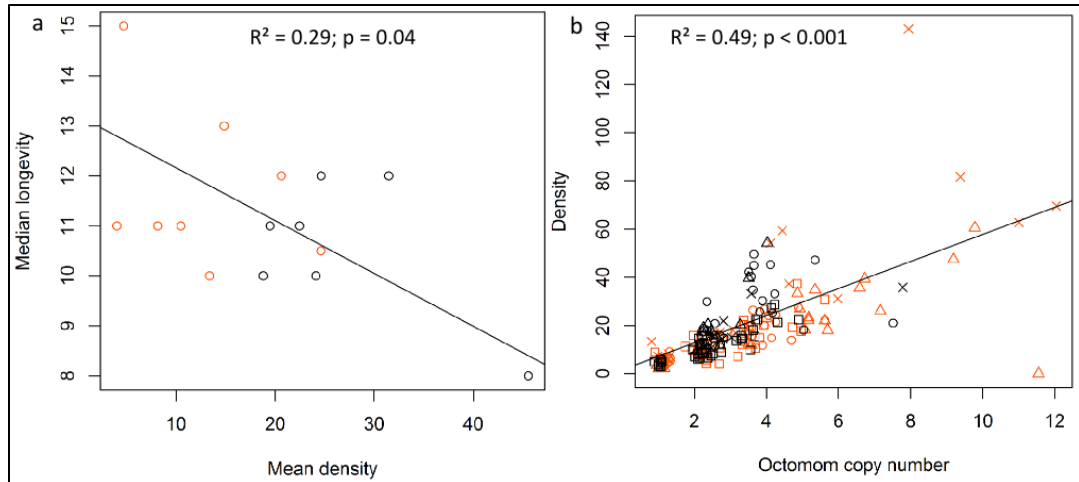
Figure 4. (a) Correlation between Wolbachia density and fly survival. Each circle represents a line in the paraquat (orange) or water (black) condition, at G9. The black line represents the regression of median longevity on mean density (data for both conditions are pooled, as the treatment effect was found not to be statistically significant). Statistics from Pearson’s correlation test are indicated. (b) Correlation between Wolbachia density and octomom copy number. Each symbol represents an individual fly, from the paraquat (orange) or water (black) condition, at G2 (squares), G9 (circles), G12 (triangles), or G17 (crosses). The black line represents the regression of density on octomom copy number. Statistics from Pearson’s correlation test, with all conditions pooled together, are